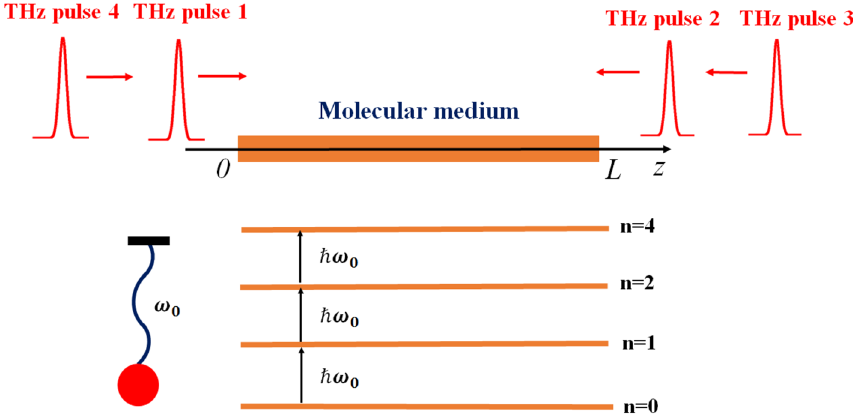
Figure 1. The simplest setup with four THz pulses counter-propagating in a medium to create a grating. Inset shows a 4-level HO molecular medium with the eigenfrequency ω 0 . This figure was created with Paint application for Windows and converted to eps using online convertor (https ://image .onlin e-conve rt.com/ru/ conve